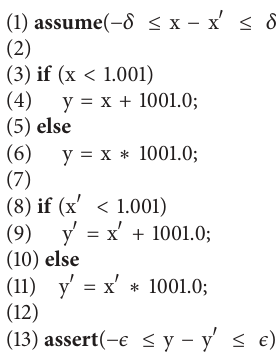
Figure 4: A floating-point program min plus1 .